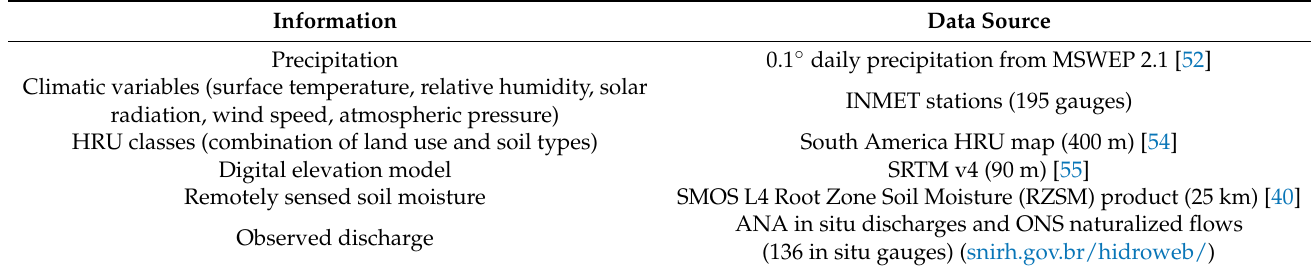
Table 1. Input data used in this